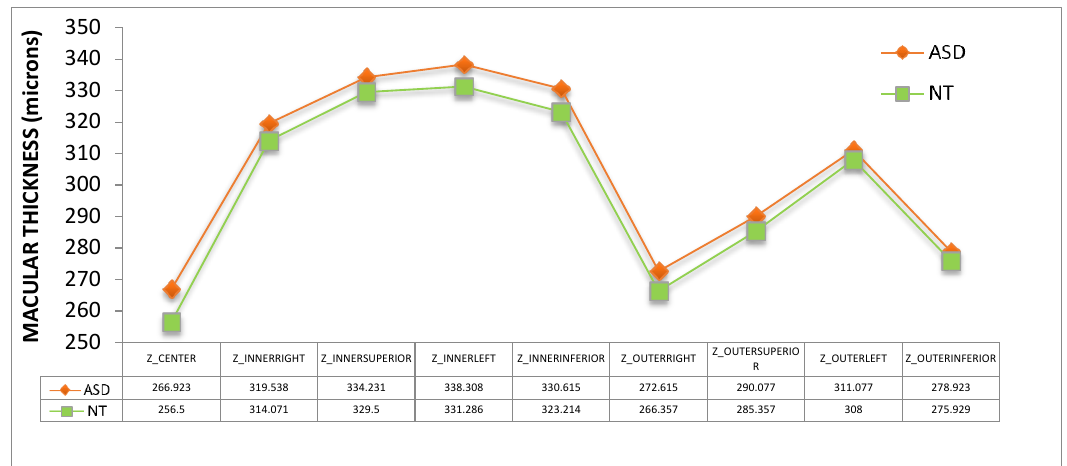
Figure 6. Retinal thickness of the nine subfields of the macular ETDRS grid. ASD = autism spectrum disorder group; NT = neurotypical group. Values represent mean thickness in microns for each group. No significant differences were detected between groups (Mann–Whitney U test).